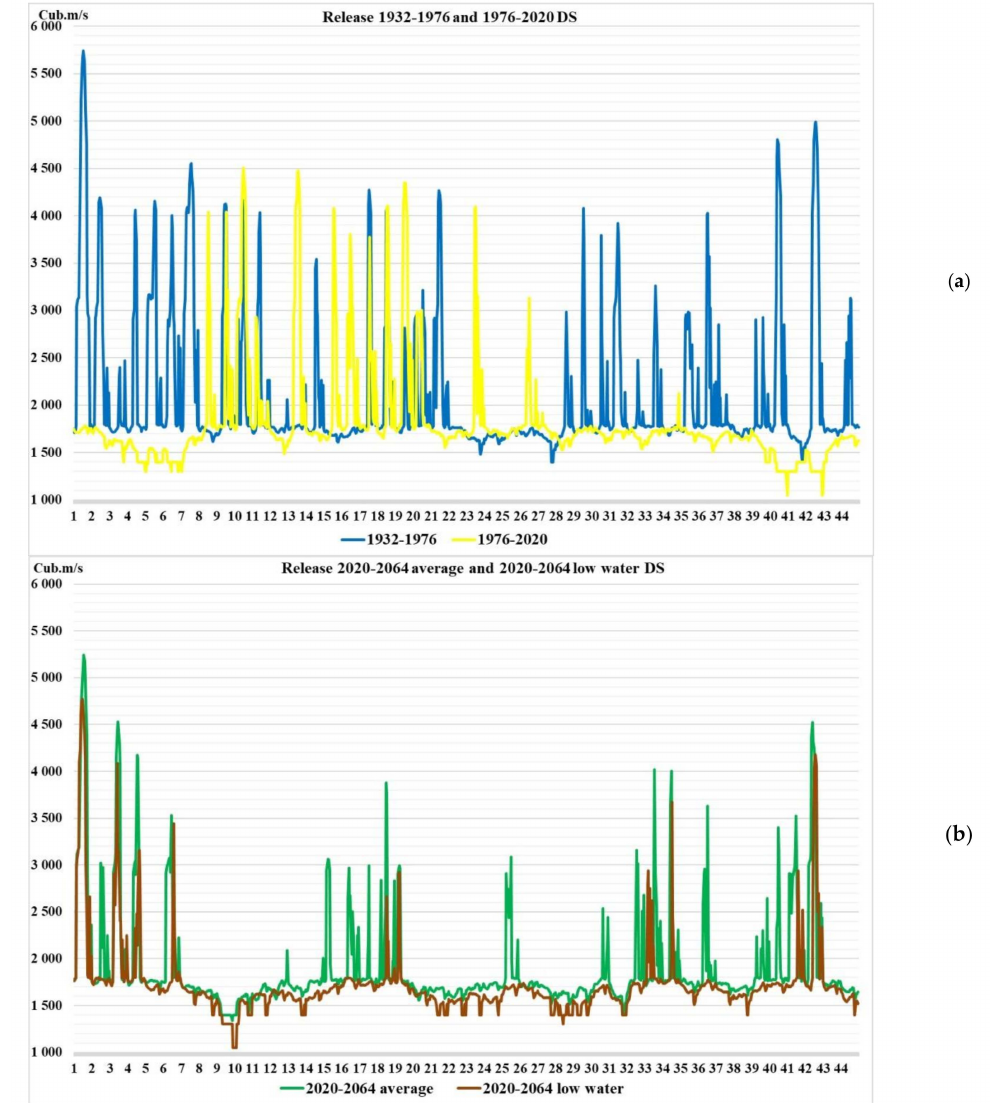
Figure 7. Releases to the Irkutsk reservoir downstream obtained as a result of WRC by DS for series 1932–1976 and 1976–2020 ( a ) for series 2020–2064 average and 2020–2064 low water ( b